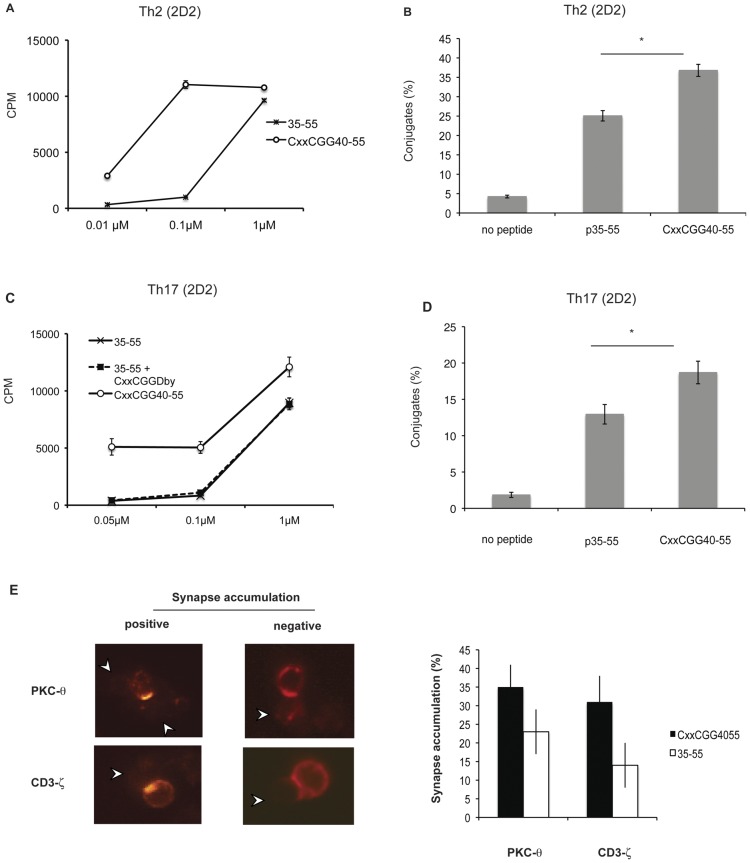
Polarized CD4+ T cells show significantly higher proliferation and conjugate formation when stimulated with peptides containing a CxxC motif.(A) CD4+CD62L+ T cells obtained from 2D2 transgenic mice were polarized by 3 cycles of stimulation under Th2 conditions by addition of IL-4, anti-IFN-γ and anti-IL-12 antibodies in the presence of 1 µM MOG35–55. On day 14 after the last stimulation, cells were cultured for 72 h with mitomycin C-treated T cell-depleted splenocytes from naive C56BL/6 mice in the presence of indicated concentrations of either MOG35–55 or MOG CxxCGG40–55. 3H-thymidine was added for the final 12 h culture. Error bars represent 1 SD. Data are representative of two experiments. (B) Conjugate formation. CD4+ T cells from 2D2 transgenic mice were polarized under Th2 conditions and MOG35–55 as described in (A). Cells were then cultured with DiOC18-stained T cell-depleted splenocytes from naive C57BL/6 mice, either unloaded, loaded with 1 µM MOG35–55 or MOG CxxCGG40–55. After 30 minutes, cells were gently resuspended, fixed for 10 minutes and analysed by flow-cytometry. Percentage of cells forming conjugates was calculated as described in Figure 1C. Error bars represent 1 SD. (*: p<0.05; unpaired t test). Data representative of two experiments. (C) CD4+CD62L+ T cells obtained from 2D2 transgenic mice were polarized by 3 cycles of stimulation under Th17 conditions by addition of TGF-β, IL-6, anti-IL-4, anti-IFN-γ, anti-IL-12 and anti-IL-10 antibodies in the presence of 1 µM MOG35–55. Proliferative response of resting cells (day14) was measured as in (A). Dotted line represents 3H-thymidine incorporation of cells incubated with indicated concentrations of MOG 35–55 peptide together with a constant concentration (5 µM) of an irrelevant peptide containing a CxxC motif (CxxC-GG-Dby). (D) The same cells as in (C) were then with DiOC18-stained T cell-depleted splenocytes from naive C57BL/6 mice, either unloaded, loaded with 1 µM MOG35–55 or MOG CxxCGG40–55. After 30 minutes, cells were gently resuspended, fixed for 10 minutes and analysed by flow-cytometry. Percentage of cells forming conjugates was calculated as described in Figure 1C. Error bars represent 1 SD. (*: p<0.05; unpaired t test) Data representative of two experiments; (E) Peptide-induced translocation of CD3-ζ and PKC-θ to the immune synapse. Th17 polarized T cells (as in D) were incubated with B cells preloaded with 30 µM MOG35–55 or MOG CxxCGG40–55. After 20 minutes, cells were gently resuspended and added to poly-L-lysine-coated slides for 25 minutes. After fixation and permeabilization, they were stained for CD3-ζ and PKC-θ. Slides were mounted and analysed by confocal microscopy. Between 25 and 75 conjugates from two experiments were analysed. Left panel shows examples of scoring for CD3-ζ and PKC-θ accumulation in conjugates. The results are shown as the average percentage of CD4+ T cells accumulating CD3-ζ and PKC-θ at the contact zone as percentage of total conjugates. White arrows indicate B cells in conjugates. Data representative of three experiments.